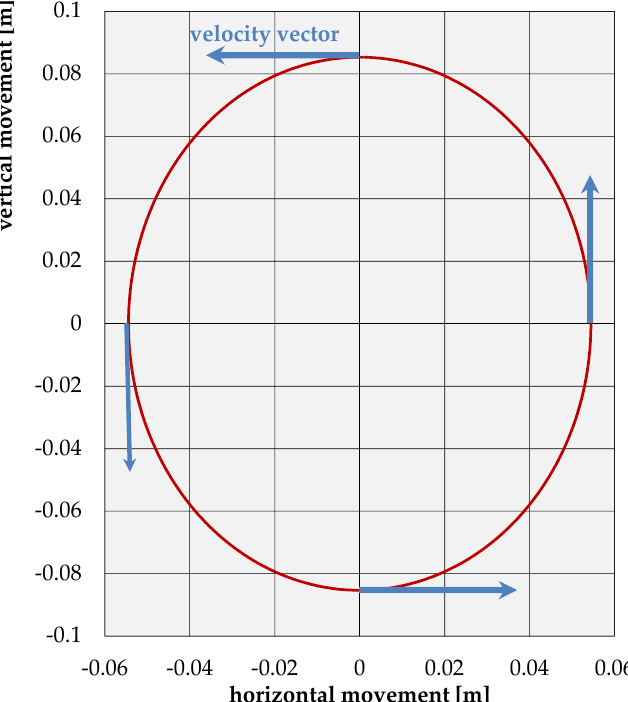
Figure 9. Displacement trajectories of the points located on the surface of an elastic half-space for the case under consideration ( ν = 1/3).